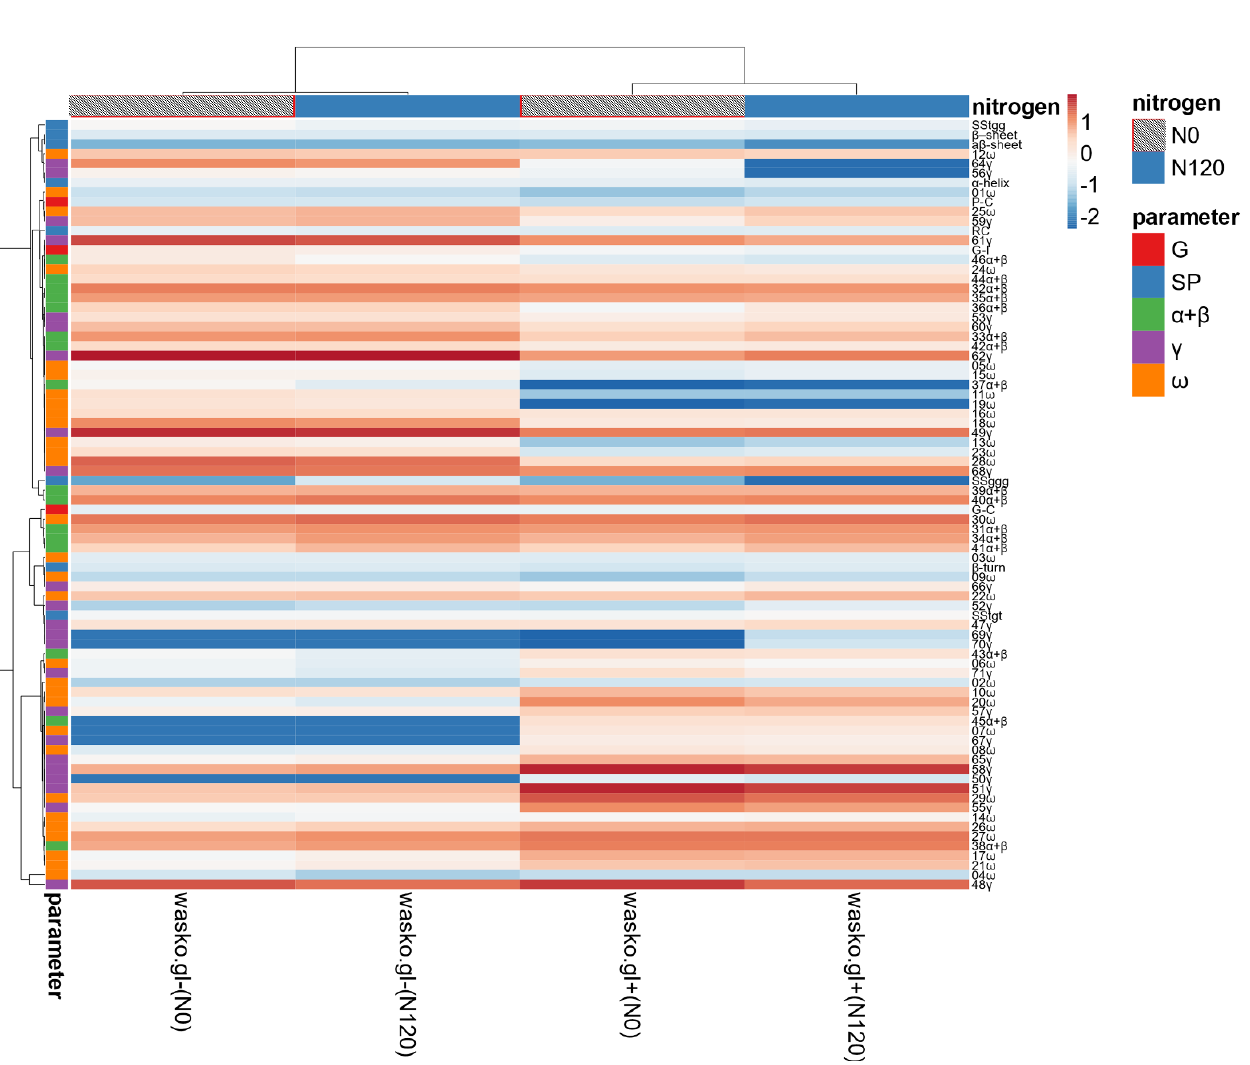
Figure 8. Heat map of analysed parameters: gluten content and index, and protein content (G); secondary structure parameters estimated from Raman spectra (SP); and proportions of gliadin fractions (α+β, γ, ω). Original values are ln(x)-transformed. Unit variance scaling is applied to columns. Both rows and columns are clustered using correlation distance and average linkage. Coloring intensity represents the relative value of a particular parameter. Red shades represent accumulation, whereas blue shades represent parameter decrease.